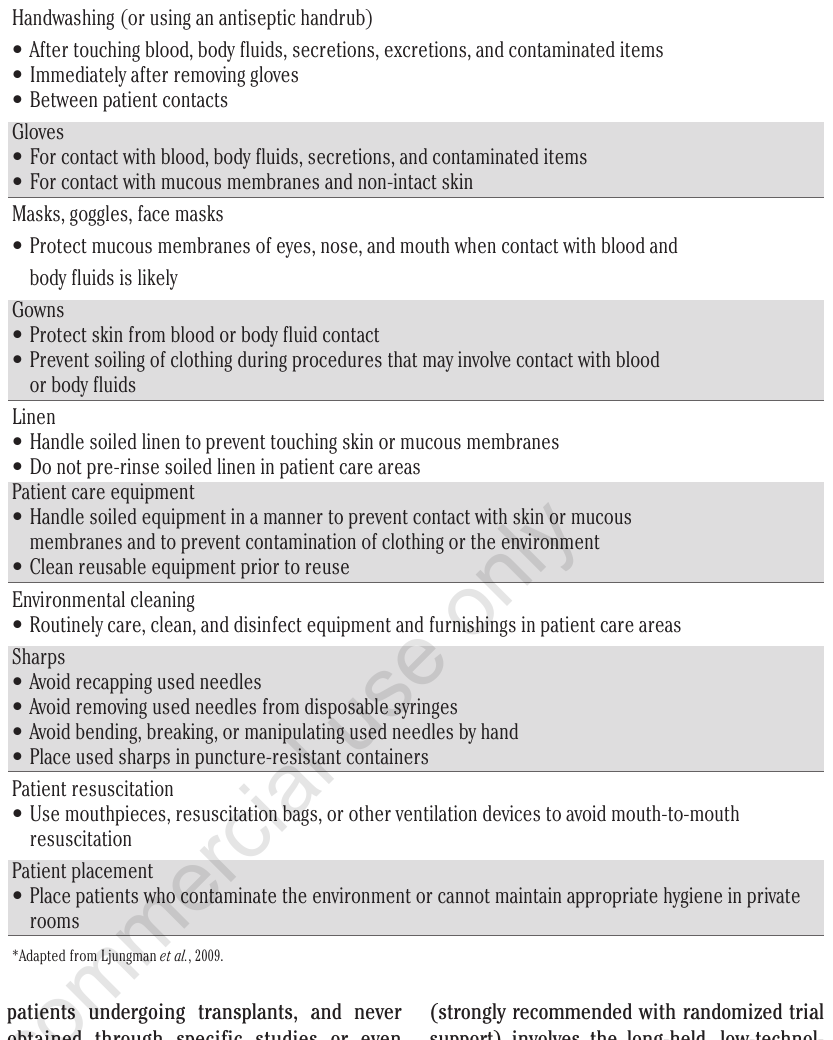
Table 1. Standard